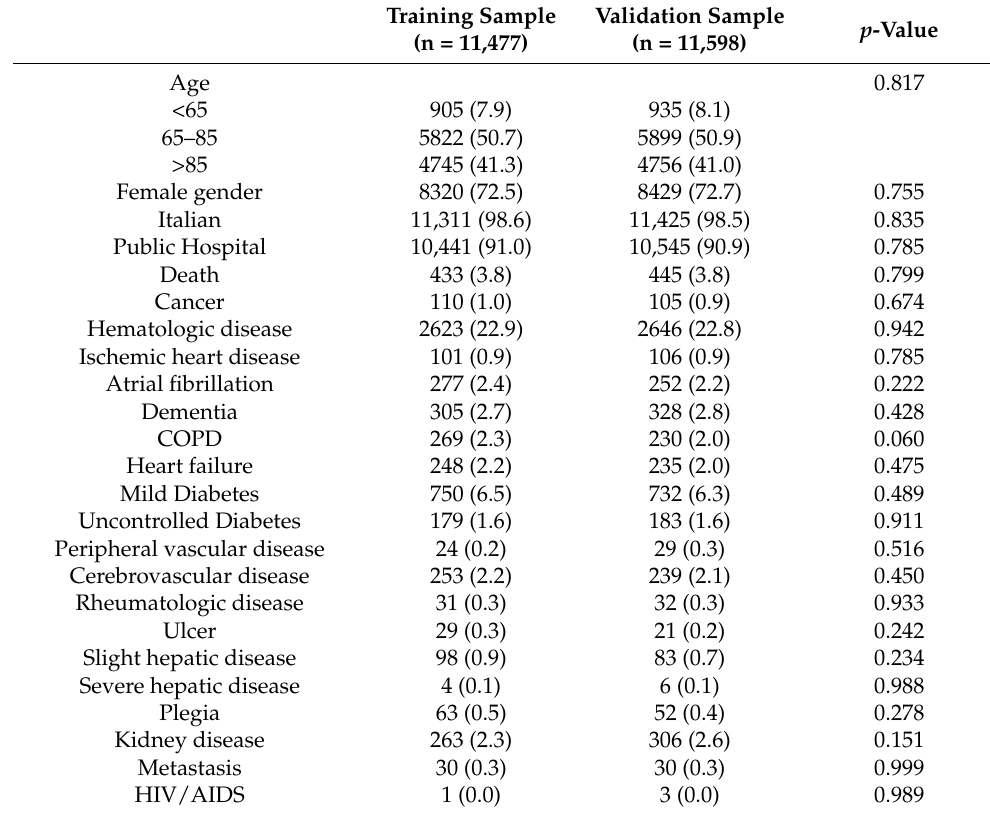
Table 1. Patient